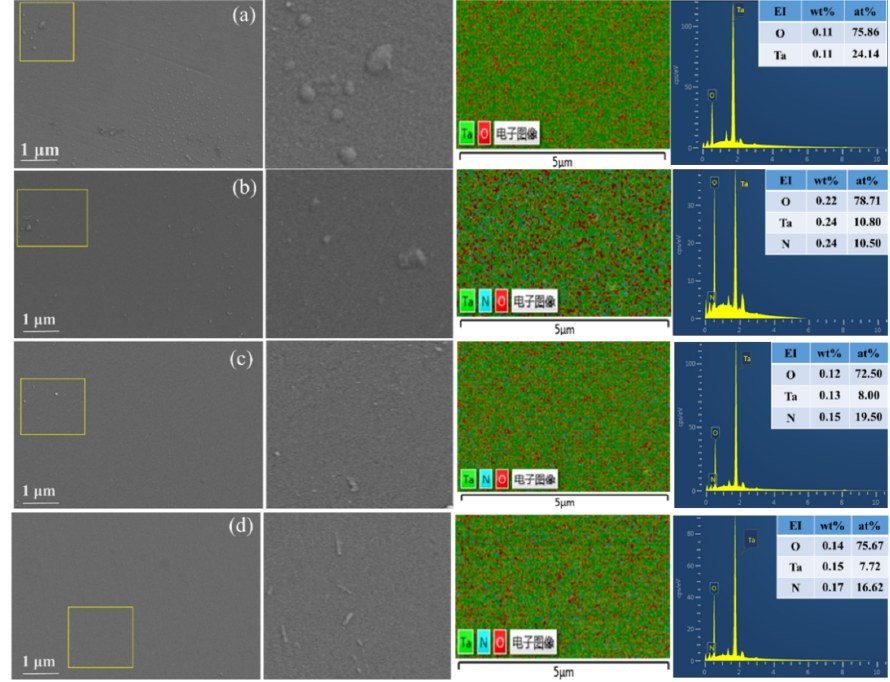
Figure 5. SEM images and EDS spectra of Ta 2 O 5 coatings prepared under different sputtering gas conditions. ( a ) 40Ar, ( b ) 36Ar–4N 2 , ( c ) 34Ar–6N 2 , ( d ) 32Ar–8N 2.